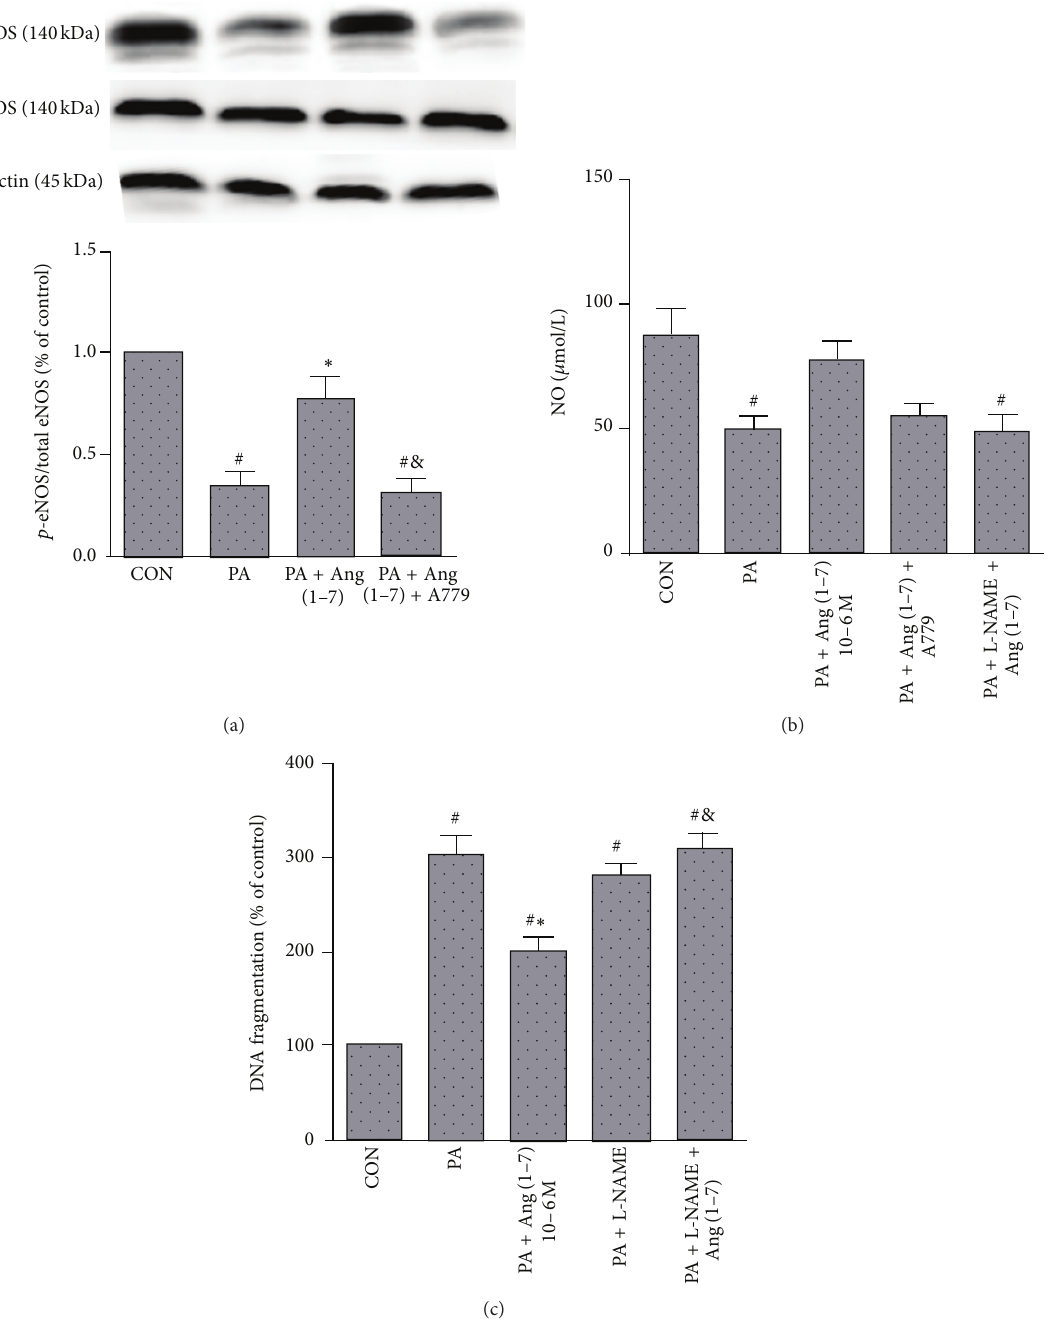
Figure 4: Effect of eNOS/NO pathway on antilipoapoptosis effect of Ang (1–7). eNOS phosphorylation (a) and NO production (b) were measured in MS-1 cells which were exposed to palmitate (0.25 mmol/L) for 24 h, alone or in combination with Ang (1–7) (10 −6 mol/L) and A779 (10 −5 mol/L). L-NAME (10 −7 mol/L) blocked the antilipoapoptosis effect of Ang (1–7) (c). Values are mean ± SEM, 𝑛 = 3 for each group. # 𝑃 < 0.05 versus CON; ∗ 𝑃 < 0.05 versus PA; & 𝑃 < 0.05 versus PA + Ang